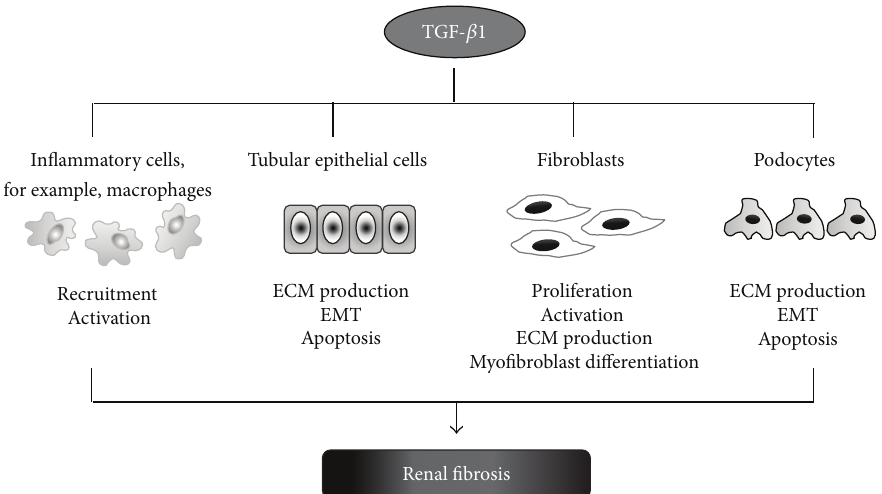
Figure 1: Role of TGF- 𝛽 1 in kidney. Multiple effects exerted by TGF- 𝛽 1 on various cells: podocytes, tubular epithelial cells, and inflammatory cells, for example macrophages, leading to their apoptosis, increased extracellular matrix (ECM) production, epithelial-to-mesenchymal transition (EMT), or